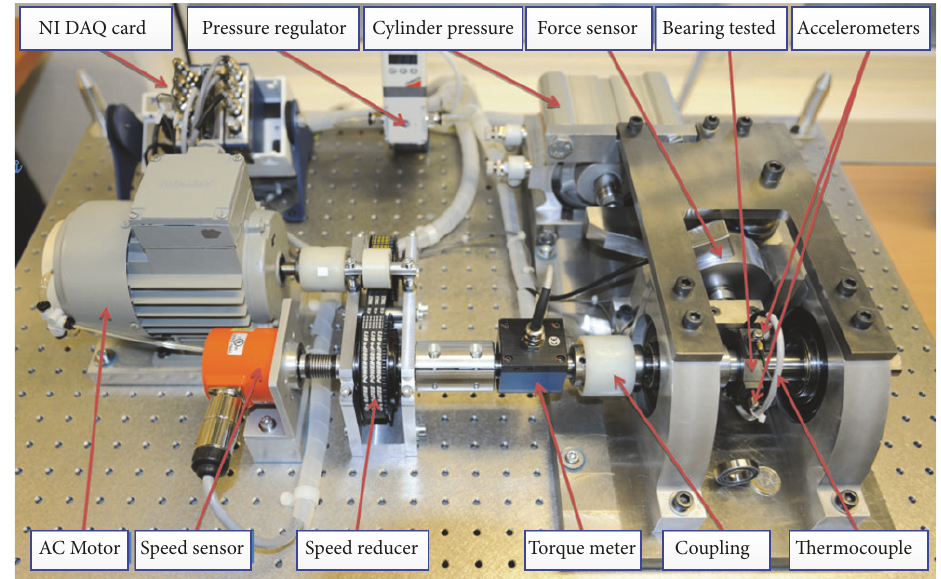
Figure 6: Overview of the experimental platform.